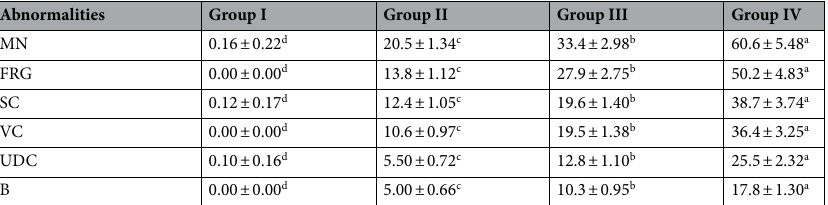
Table 2. MN and CAs frequencies induced by MnCl 2 . Group I: Control, Group II: 250 µM MnCl 2 , Group III: 500 µM MnCl 2 , Group IV: 1000 µM MnCl 2 . Data are shown as mean ± SD (n = 10). MN and CAs were calculated by analyzing 1000 cells in each group, and MI by analyzing 10,000 cells in each group. The averages shown with different letters (a–d) in the same line are statistically significant at p < 0.05. MN micronucleus, FRG fragment, SC sticky chromosome, VC vagrant chromosome, UDC unequal distribution of chromatin, B bridge.